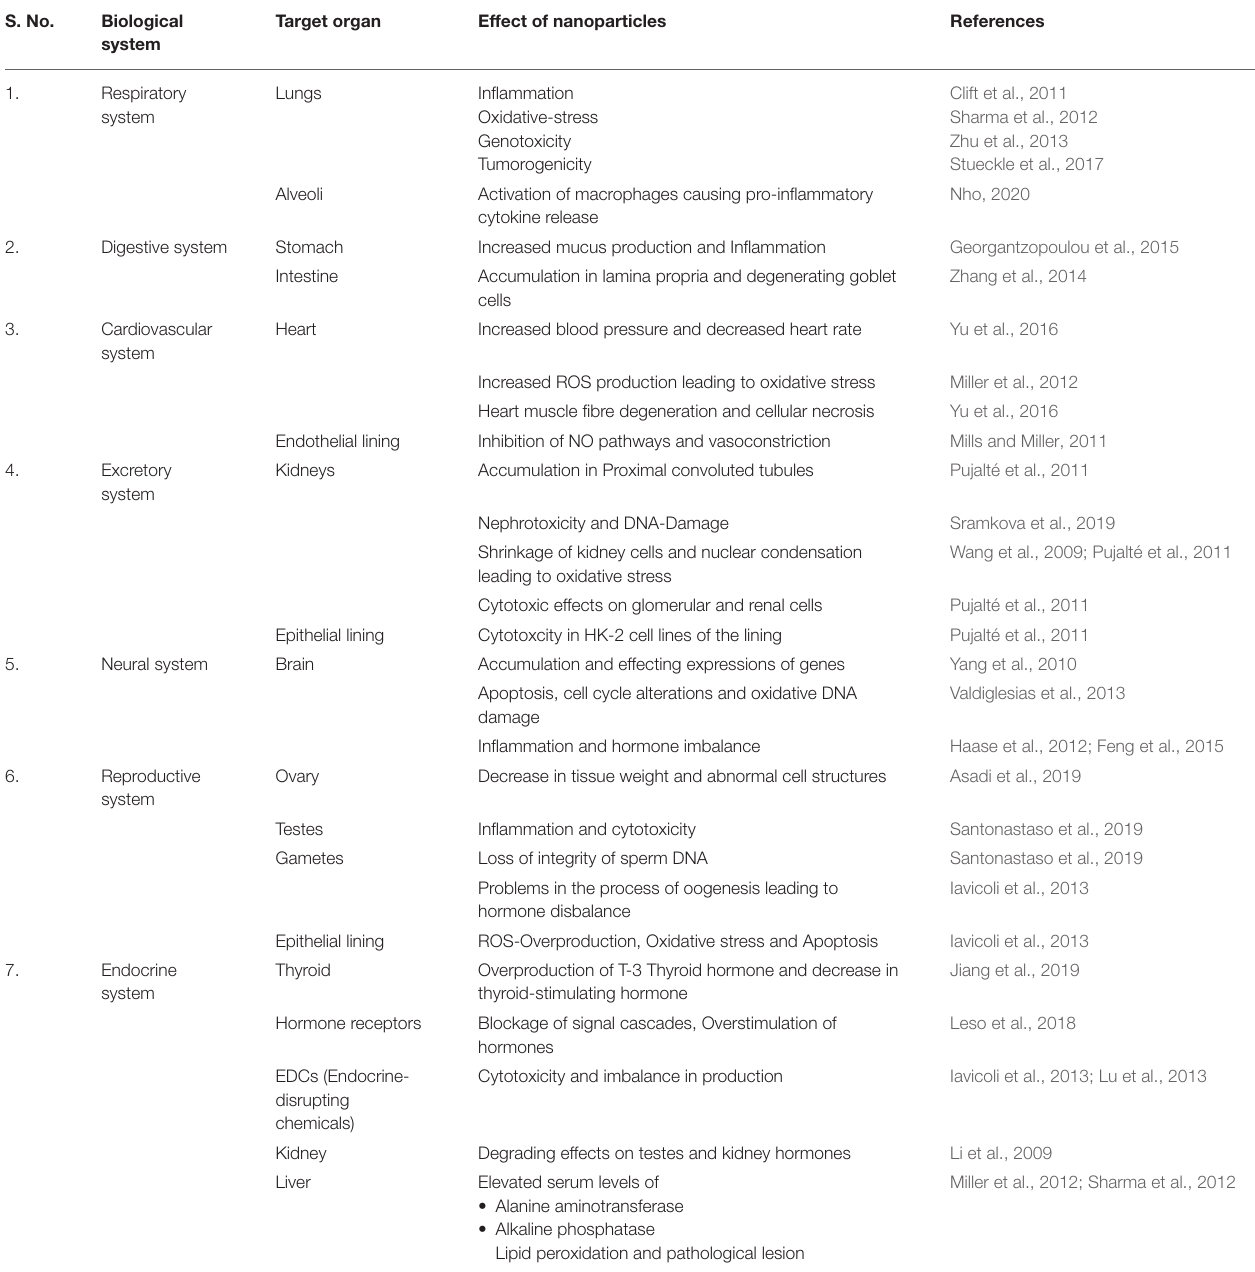
TABLE 1 | Summary of effects of nanoparticles on various organs and organ systems of the human body. S.